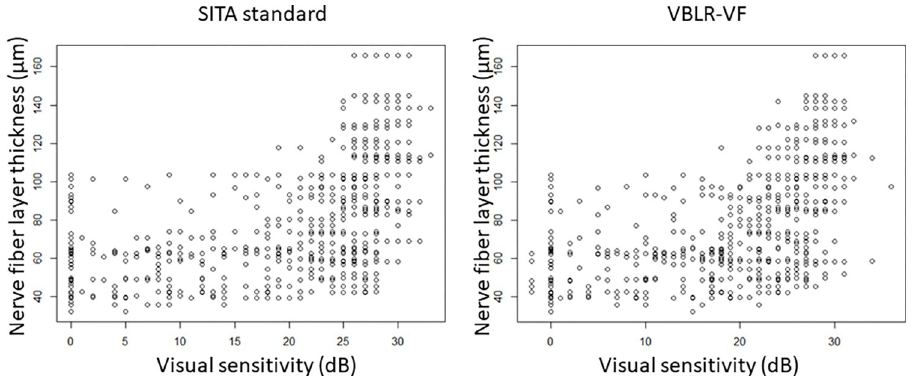
Fig 3. Relationship between visual sensitivity and cpRNFL (sector 10). The relationship between visual sensitivity and cpRNFL in sector 10 is shown. cpRNFL, circumpapillary retinal nerve fiber layer, SITA, Swedish interactive thresholding algorithm; VBLR, variational Bayes linear regression; VF, visual